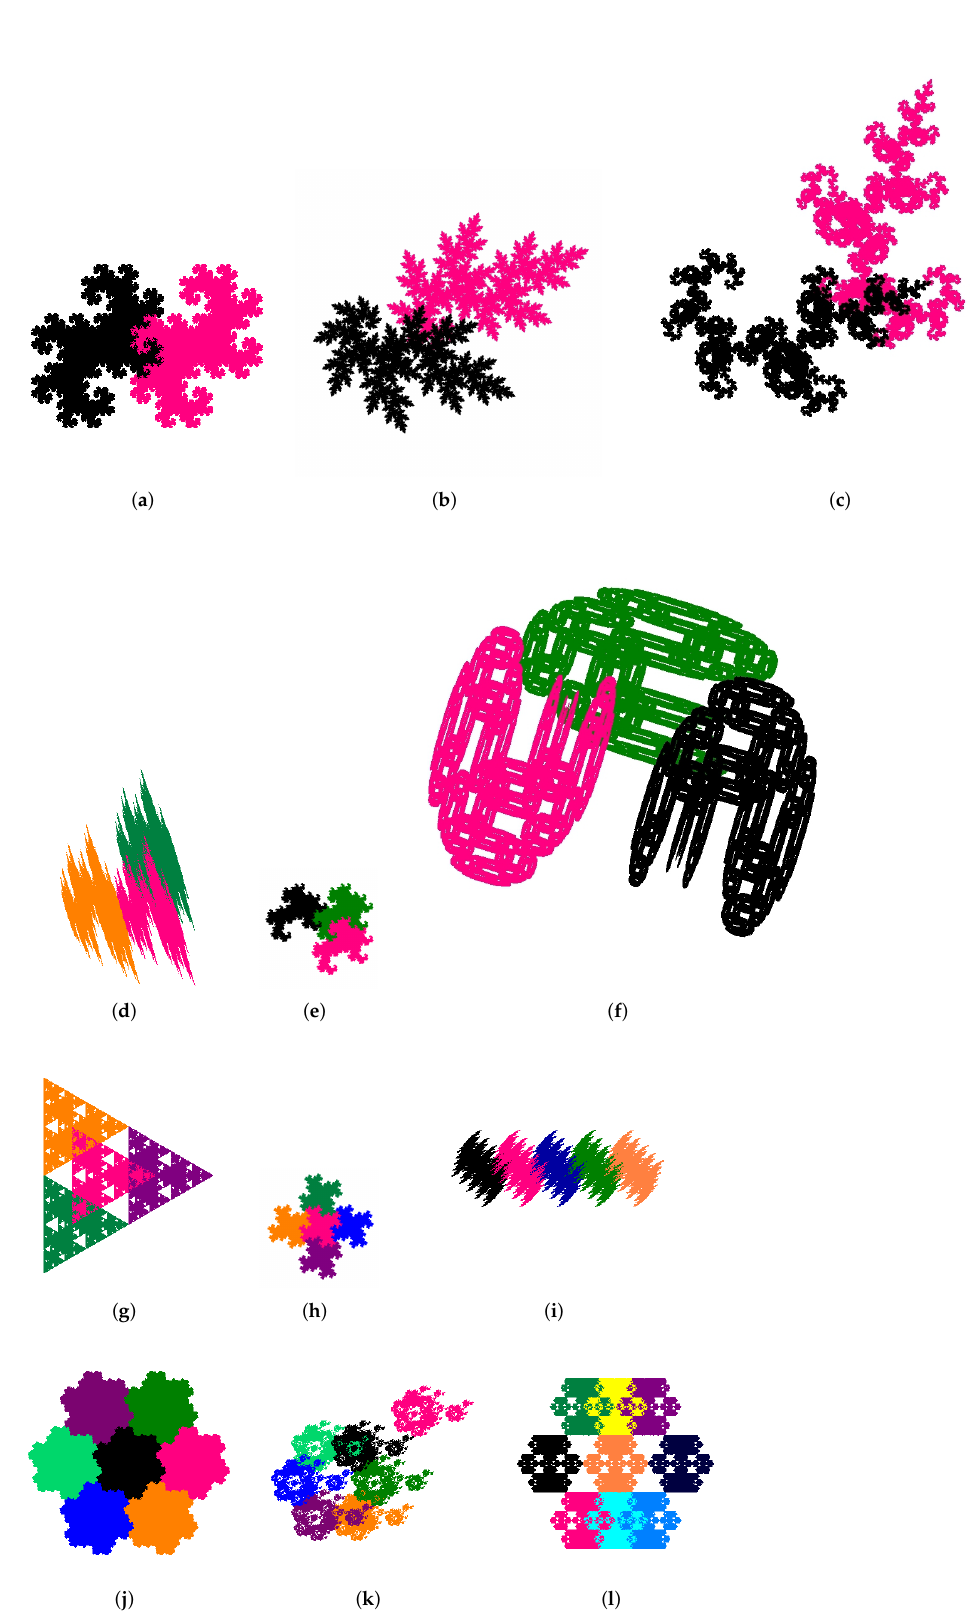
Figure 11. Examples of fractal rep tiles rendered by IFS Construction Kit [42] package. ( a – c ) 2 − rep tiles, ( d – f ) 3 − rep tiles, ( g ) 4 − rep tile, ( h , i ) 5 − rep tiles, ( j , k ) 7 − rep tiles, and ( l ) 9 − rep